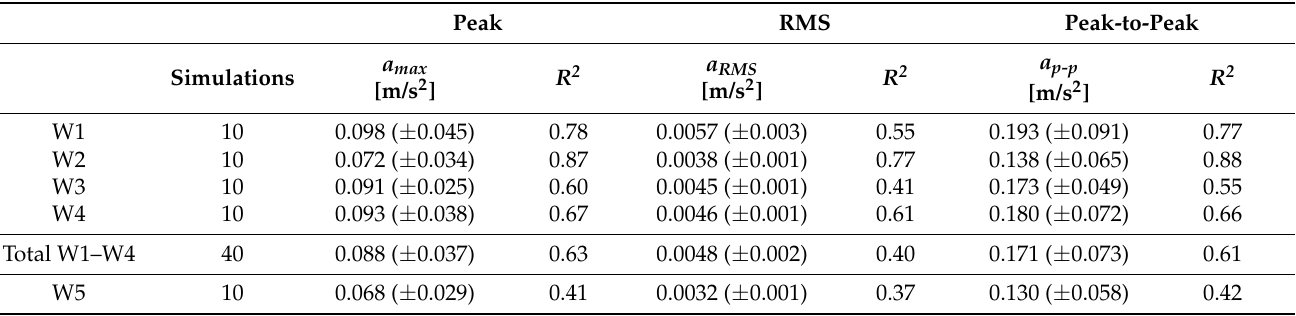
Table 7. Analysis of the examined concrete slab under synthetized body CoM stride acceleration (example for experimental stride from signal #7-W1), with maximum acceleration, RMS value, peak- to-peak acceleration, and CREST factor.